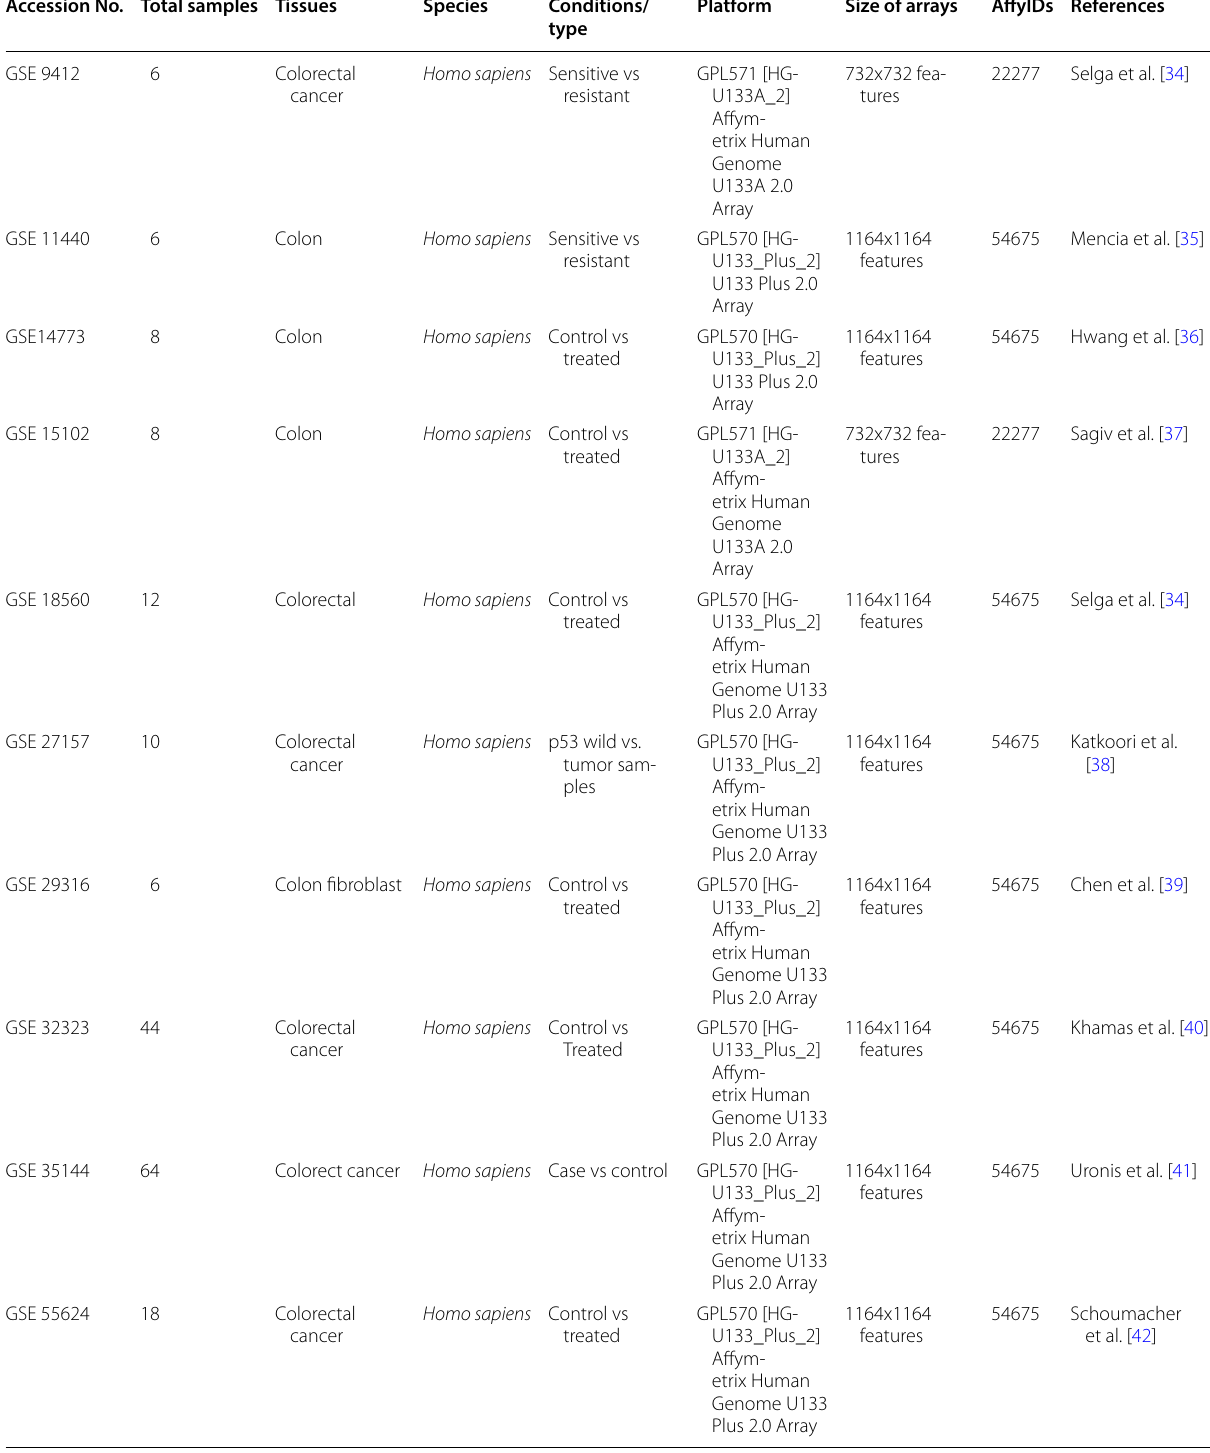
Table 1 List of cDNA datasets Accession No. Total samples